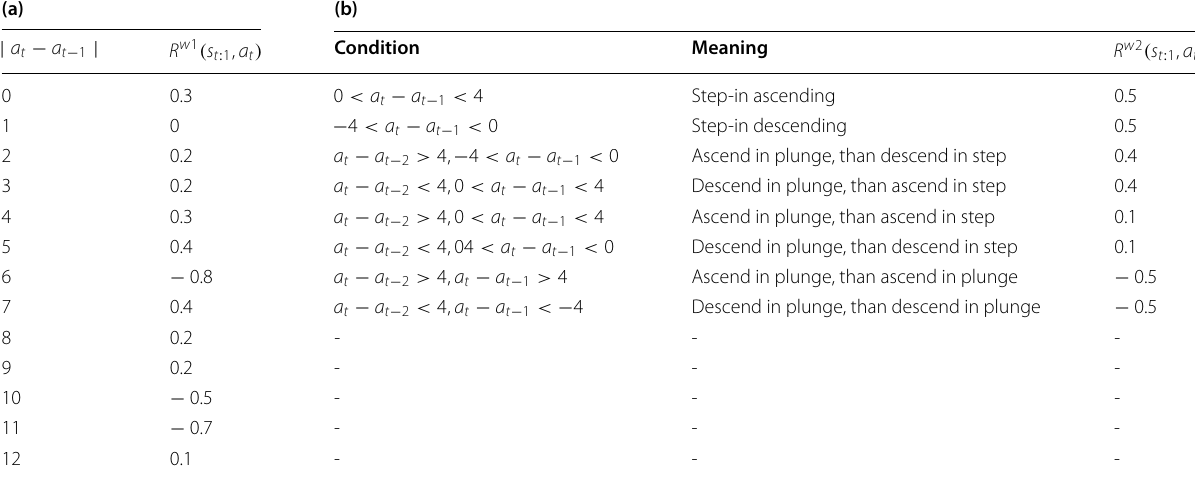
Table 2 Melodic writing incentives: (a) melodic interval reward; and (b) melodic tone towards reward (a)